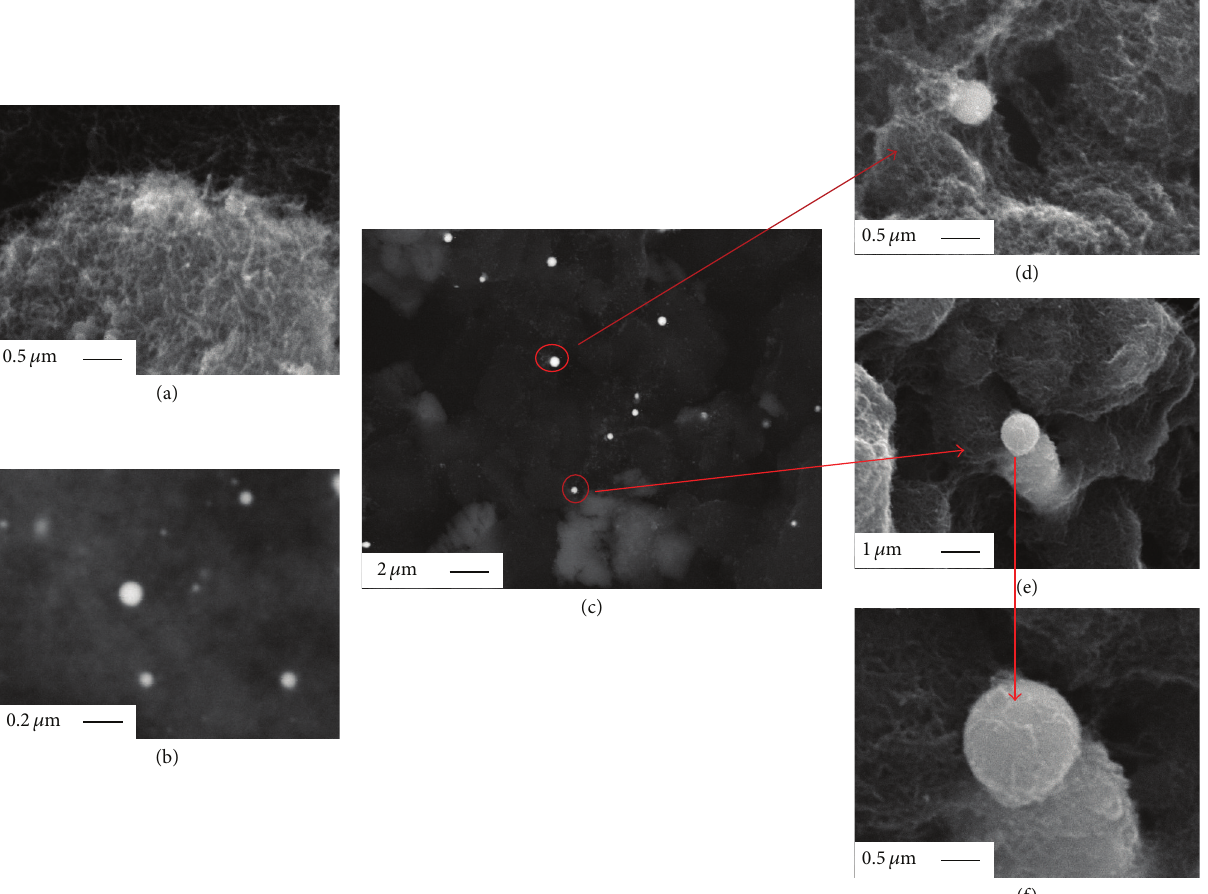
Figure 1: SEM images of Ag/CNT sample: (a) BSE image and (b) corresponding SE image of sample produced by process A. (c) BSE and (d) SE details on silver microparticles; (e-f) SE images of a silver microparticle completely covered by